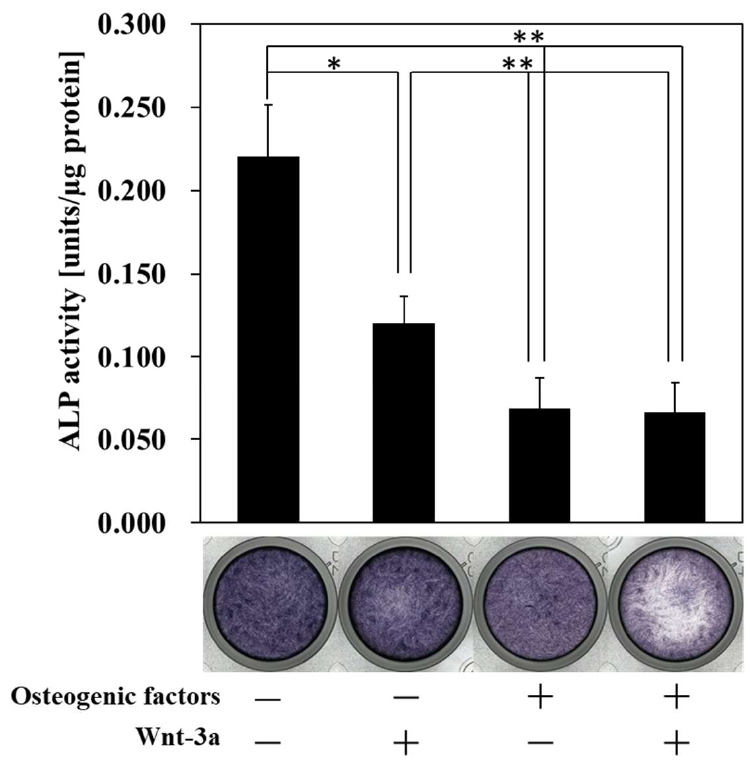
Figure 3. ALP activity measurement and ALP staining after treatment with Wnt-3a. HPLFs were treated with osteogenic medium and Wnt-3a for 14 days ( A , B ). ALP staining showed that the staining around the center was uneven when (+/+) was used. There was a significant decrease in ALP activity in ( − /+), (+/ − ) and (+/+) compared to ( − / − ). And there was no significant difference between (+/ − ) and (+/+). ALP activity and staining were carried out using a kit. Data represent the means ± S.D. * p < 0.05, ** p < 0.01, (n = 3).